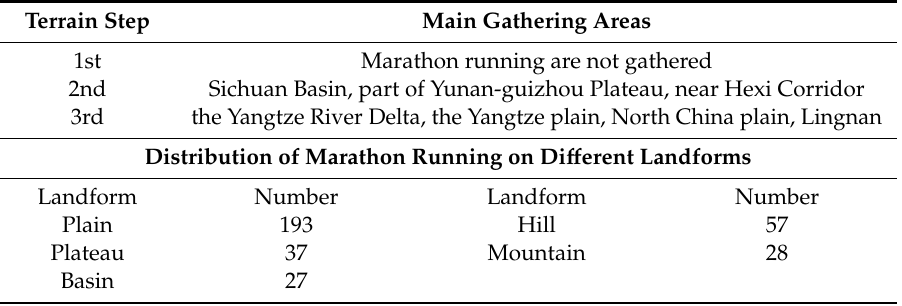
Table 2. Main gathering area on each terrain step and the distribution of marathon events on di ff erent landforms.